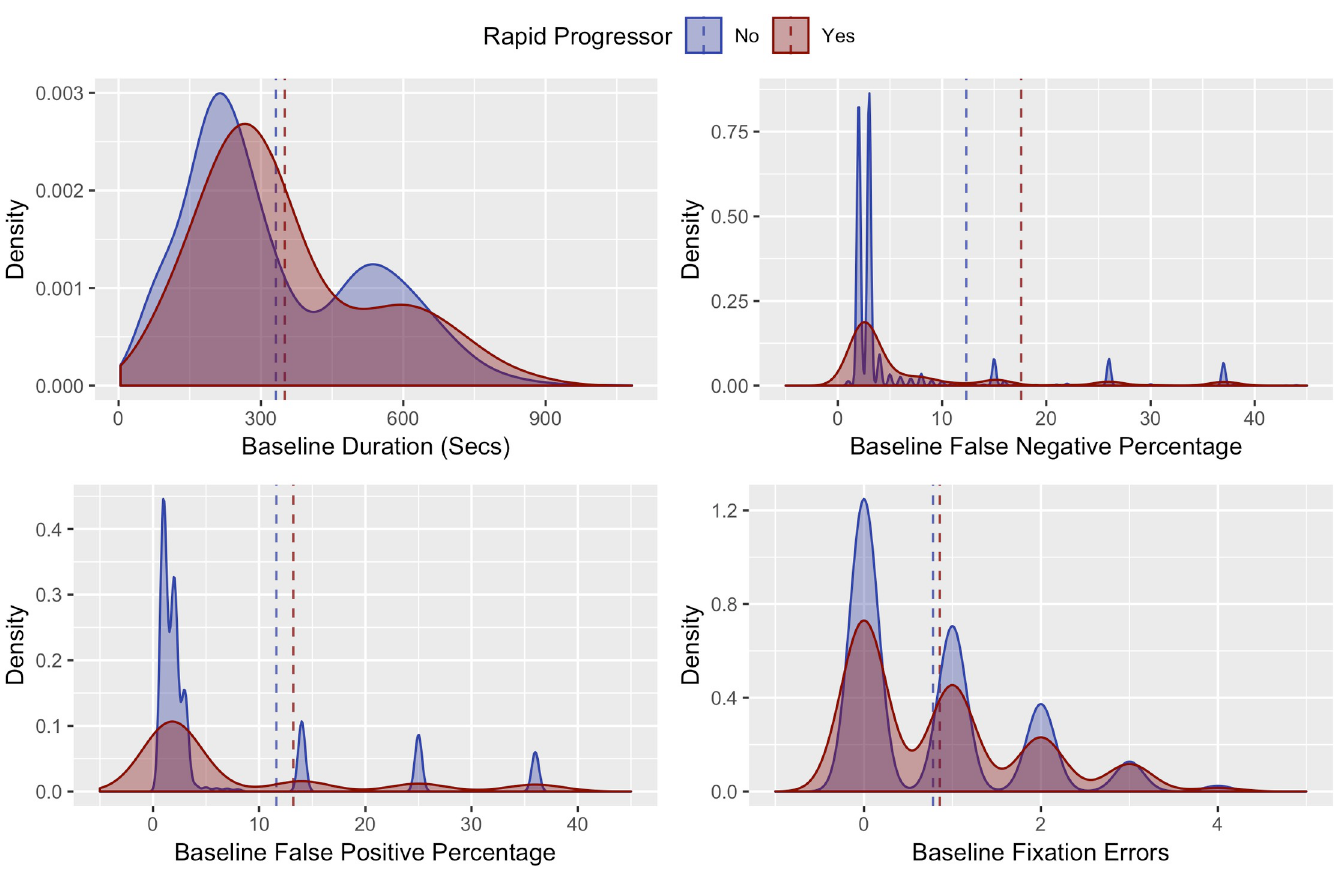
Fig 3. Density plots of rapid (red) and non-rapid (blue) progressors by VF reliability indices (false negative responses, false positive responses and fixation losses) at baseline. Dashed lines indicate mean values for the independent variables in rapid (red) and non-rapid (blue) progressors.